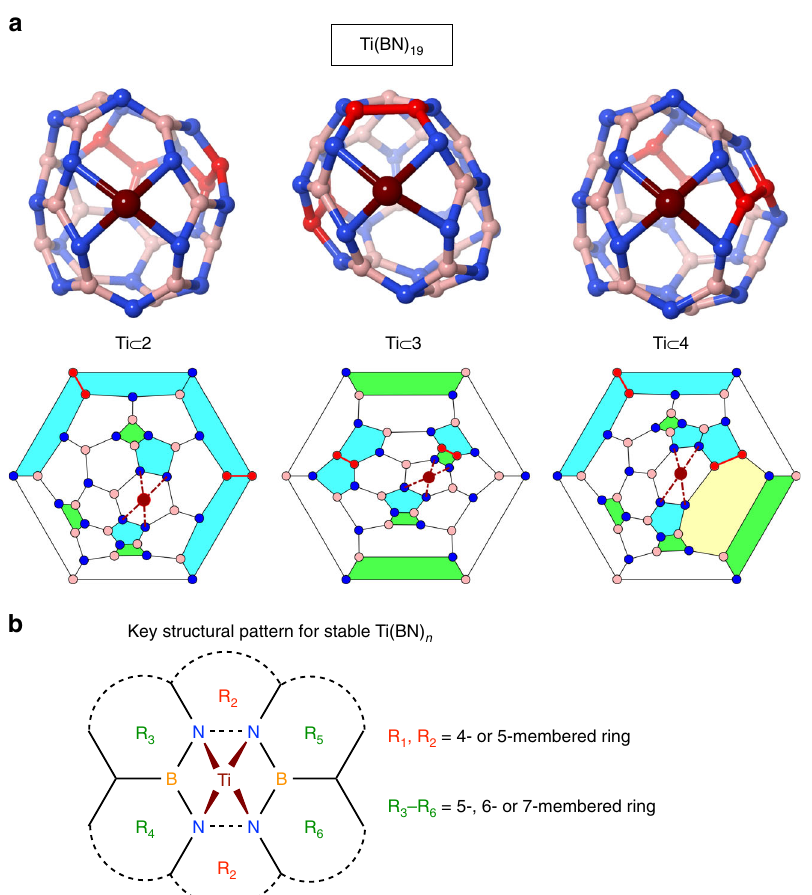
Fig. 2 Global minimum energy structures of Ti(BN) 19 , revealing common bonding features. a Molecular structures (upper panel) and Schlegel diagrams (lower panel) of the three global minimum isomers (almost degenerate within an energy difference of 0.7 kcal mol − 1 ). Boron, nitrogen, and titanium atoms are depicted in pink, blue, and dark red, respectively. The two B – B bonds in each molecule are highlighted in red. In Schlegel diagrams, Ti – N bonds are indicated by dashed lines, and squares, pentagons, hexagons, and heptagon are shown in green, cyan, white, and yellow, respectively. b The key structural pattern present in all stable Ti-doped (BN) n cages. The Ti atom is located above a hexagonal ring, where four N atoms sit on two parallel sides and two B and R ) adjacent to the doped hexagon are preferably squares or atoms at opposite corners. To achieve higher stability, the top and bottom rings ( R 1 2 pentagons, while the four lateral neighboring rings ( R 3 – R 6 ) opt for pentagons, hexagons, or